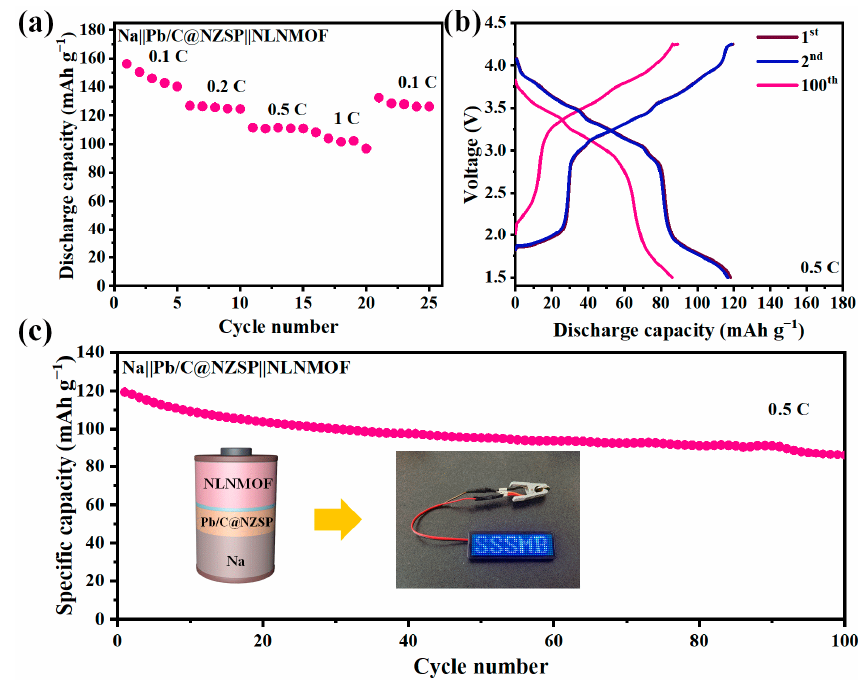
Figure 7. ( a ) The rate and ( c ) cycling performance of the solid-state Na||Pb/C@NZSP||NLNMOF battery between 1.5 V and 4.25 V. ( b ) The charge–discharge profiles for the 1st, 2nd, and 100th cycles.